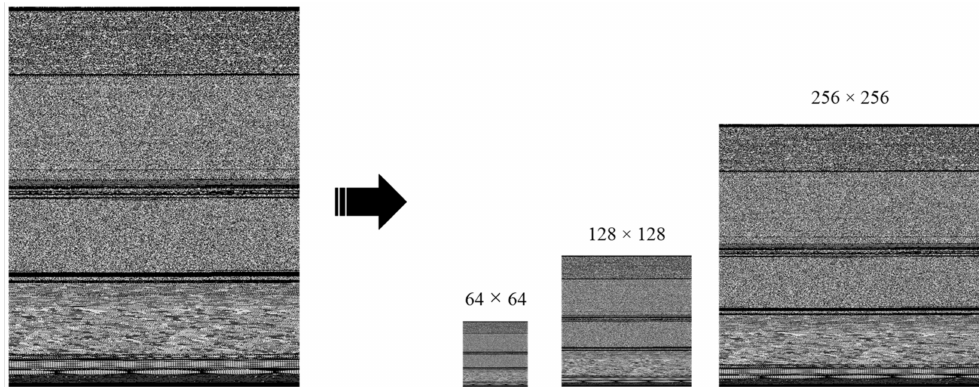
Figure 3. Malware samples after size